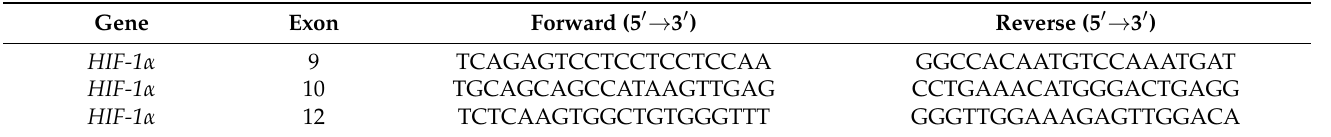
Table 1. Primer information for the three exons of HIF-1 α